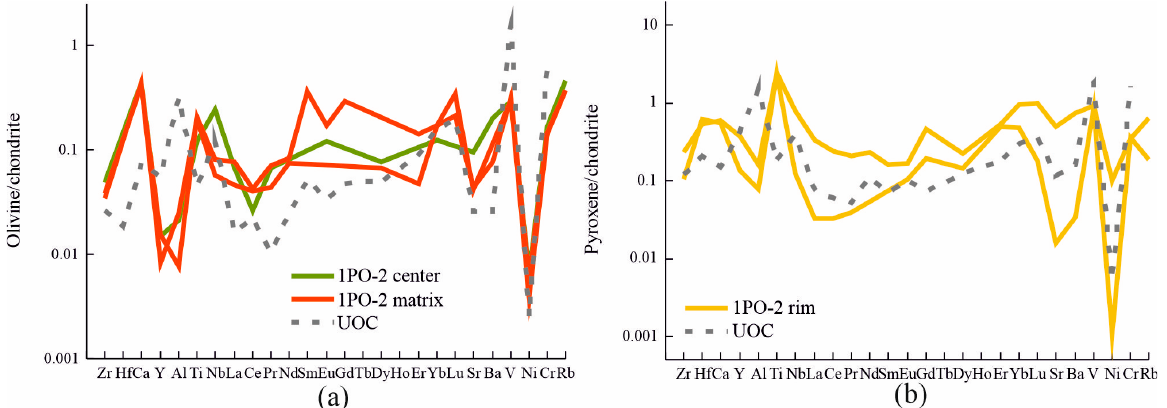
Figure 4. CI chondrite-normalized trace element patterns of olivine ( a ) and pyroxene ( b ) of 1PO-2 chondrule and matrix.